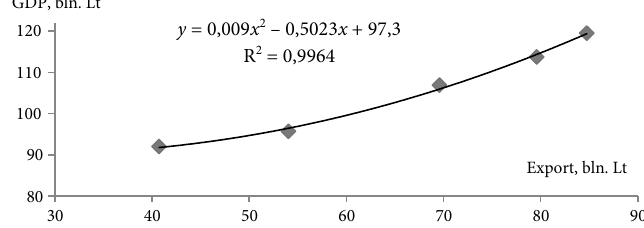
Fig. 5. The relationship between export and GDP, 2009 to 2013 Source: Authors’ calculations based on the Statistics Lithuania data (2015).